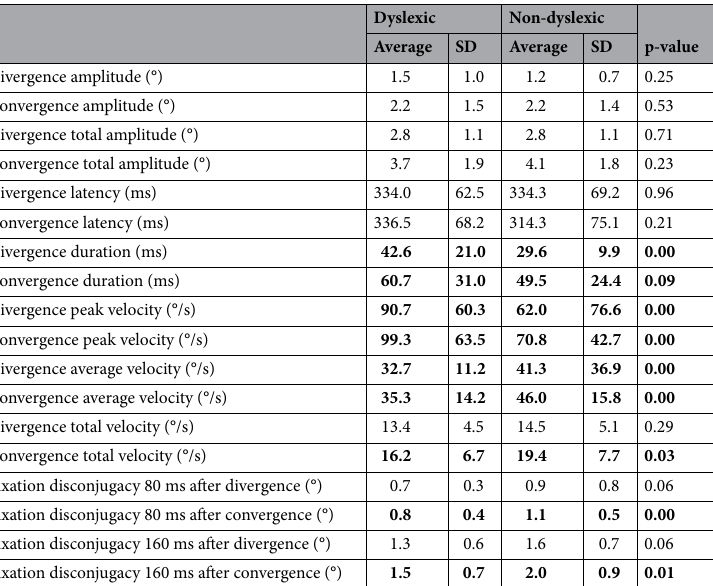
Table 1. Means and standard deviations of vergence parameters in dyslexic and non-dyslexic adolescents. Variables with significant differences between the two populations (p < 0.05) are